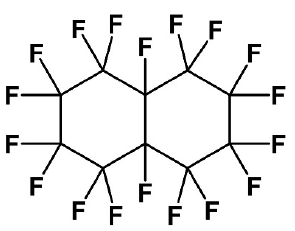
Figure 1. Structure of perfluorodecalin (PFD).